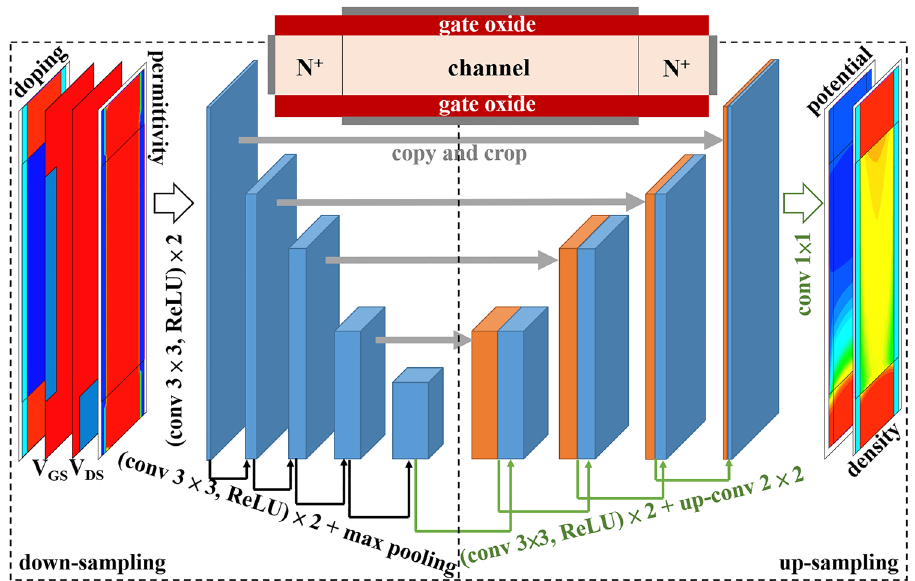
Figure 1. A schematic structure of a U-Net with down- and up-sampling procedures within the dashed frame. The down-sampling procedure begins with four input parameters matrixes, and then the data is processed by two convolutional layers and one max pooling layer. Each layer is copied and concatenated from the up-sampling to the down-sampling procedure. The upper insert is a schematic device structure with the following settings in TCAD simulations: doping density in source/drain (1 × 10 20 cm −3 ) and channel (1 × 10 15 cm −3 ) regions; channel thickness (5 nm) and length (30 nm); gate effective oxide thickness ( EOT = 1 nm); gate work function (4.5